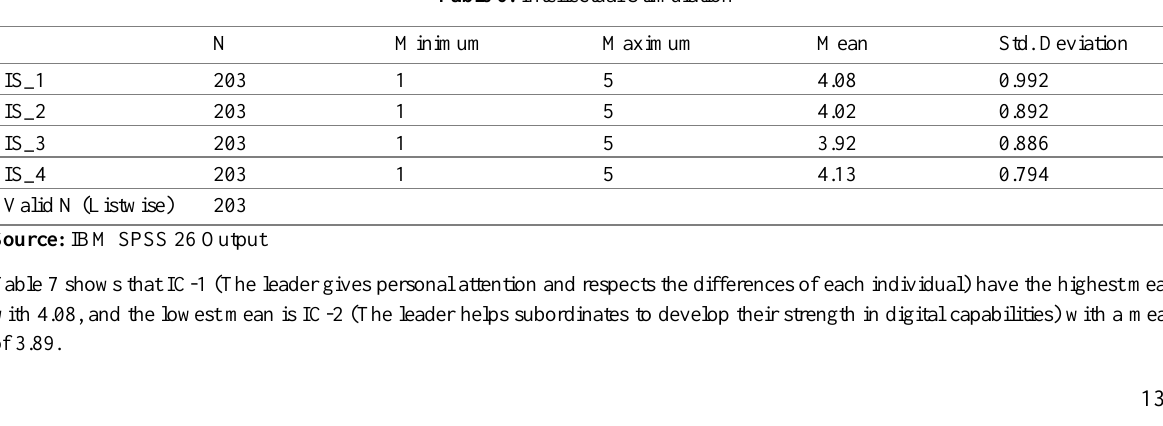
Table 6: Intellectual